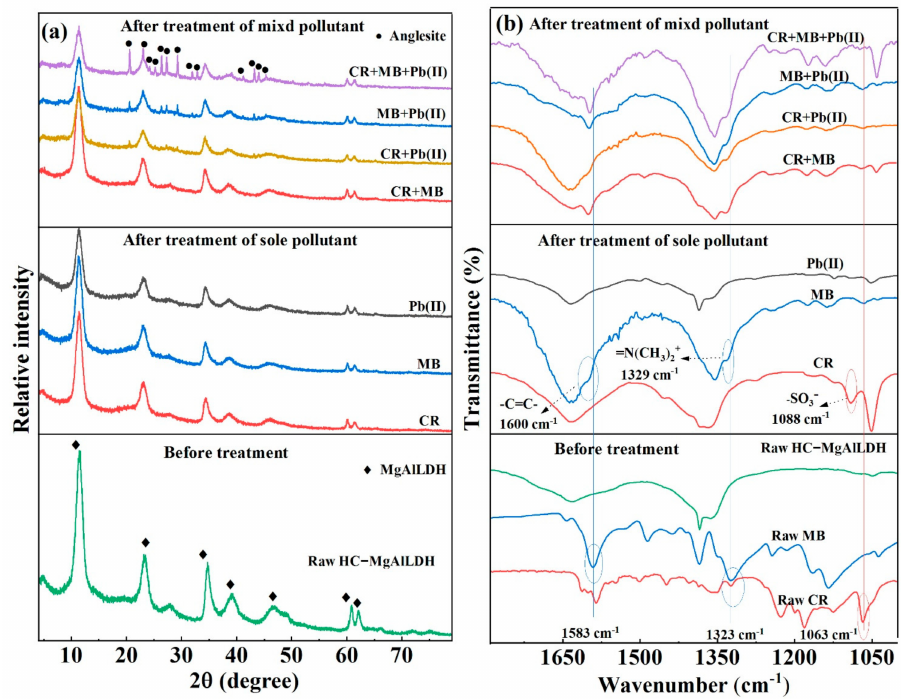
Figure 7. XRD patterns ( a ) and FT-IR spectra ( b ) of the HC–MgAlLDH nanocomposite before and after treating CR, MB and Pb(II).